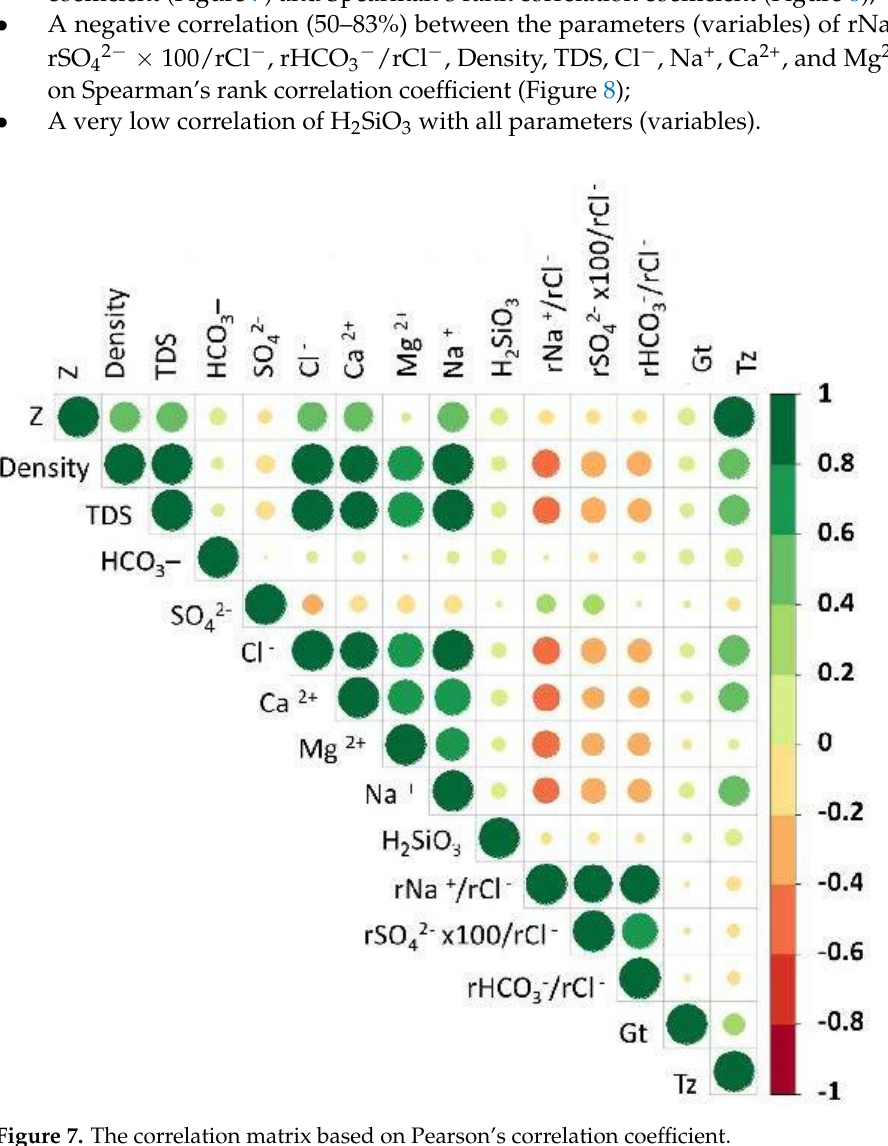
Figure 7. The correlation matrix based on Pearson’s correlation